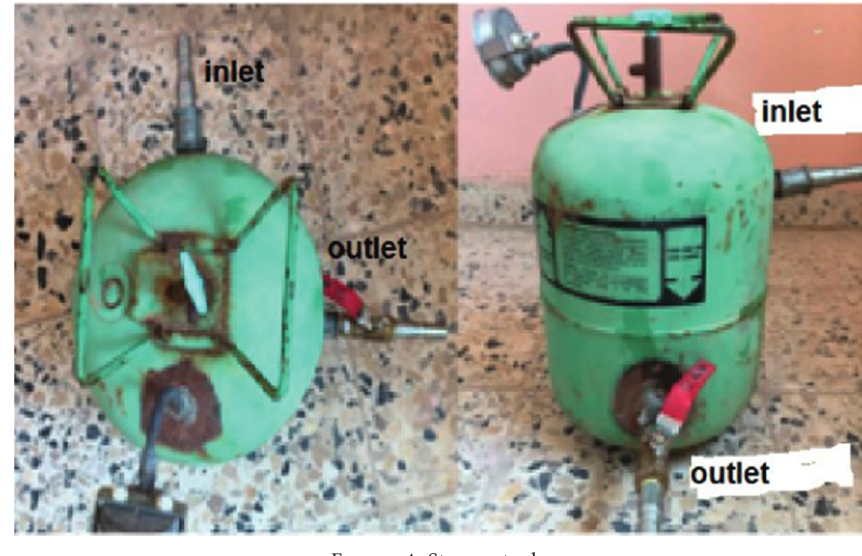
Figure 4: Storage tank.